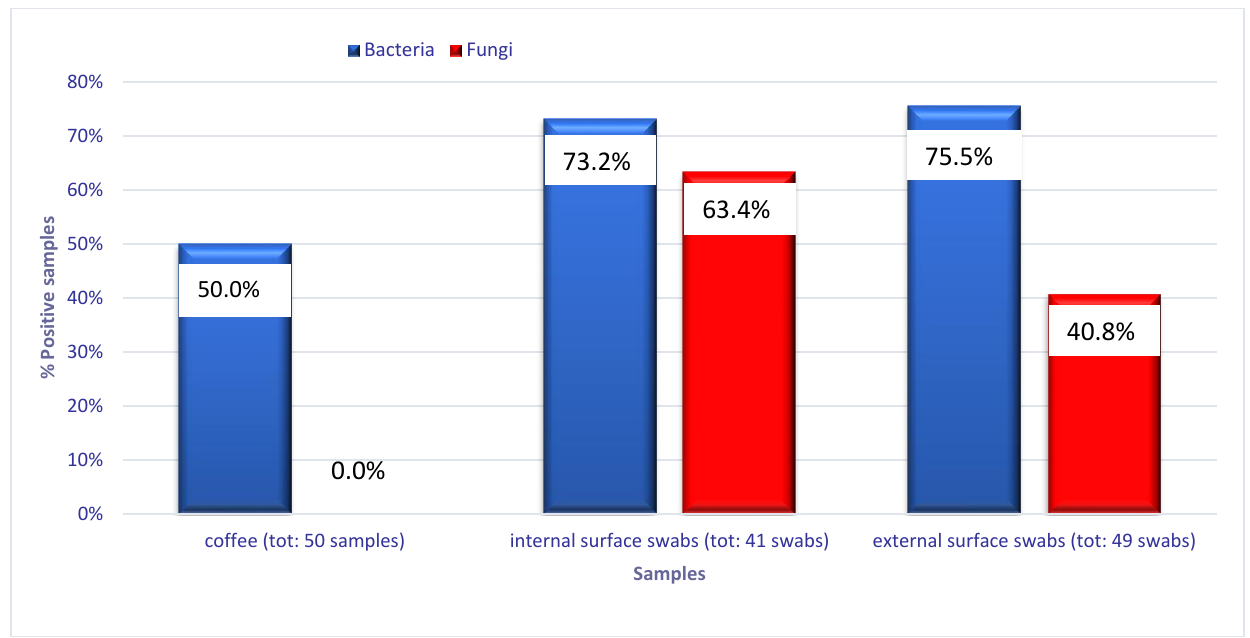
Figure 2. Positive samples (%) of coffee and internal/external surfaces of FVMs.